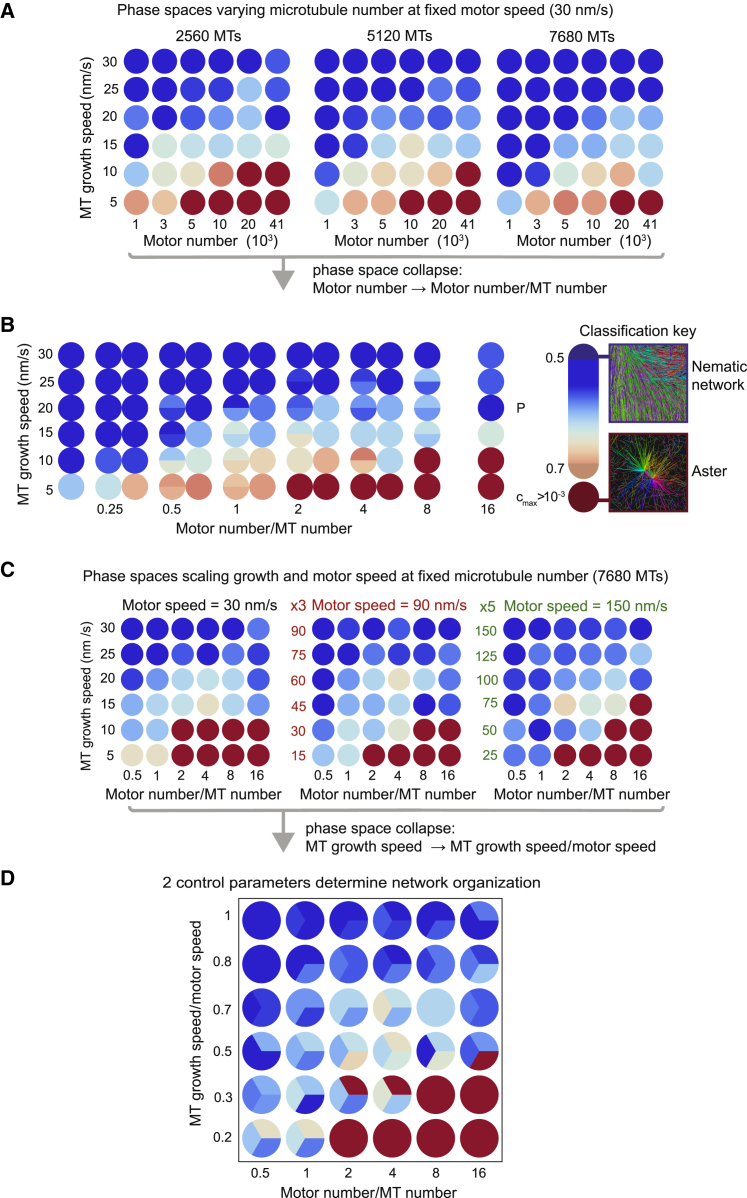
Computational Exploration of the Multi-Dimensional Parameter Space of Microtubule/Motor Networks Reveals Critical Parameters Driving Active Network Organization(A) Three phase spaces showing the organizational state of the network as a function of microtubule growth speed and motor number at three different numbers of microtubules. Simulation outcomes are classified (Figure S5; STAR Methods) and color-coded (see “Classification key”). Each circle represents one simulation.(B) Phase spaces in (A) can be collapsed onto a single space by plotting the classified states as a function of growth speed and the number of motors per microtubule. Where simulations are coincident in the collapsed phase space the circle is divided between them.(C) Three collapsed phase spaces for three different motor and microtubule speed scalings. Speeds are increased by a factor of 3 (middle) and 5 (right).(D) Phase spaces in (C) can be collapsed onto a single space by plotting the classified states as a function of the ratio of growth speed to motor speed and the number of motors per microtubule. For all simulations see Table S1 for parameter values if not shown.See also Figure S6.